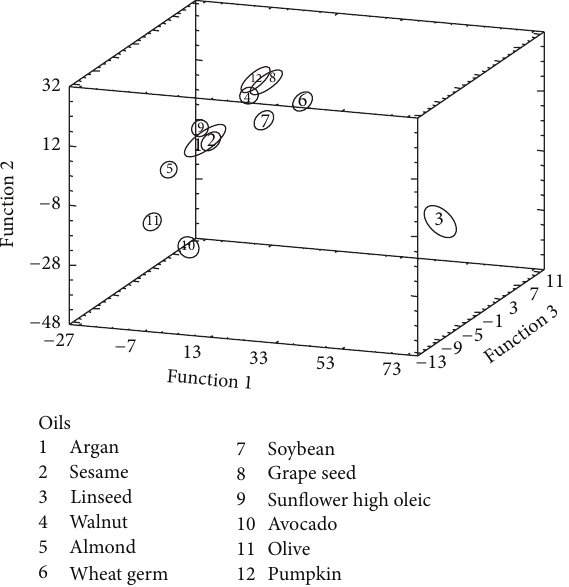
Figure 2: Similarity of the oils based on the first three discriminat- ing functions of the discriminant